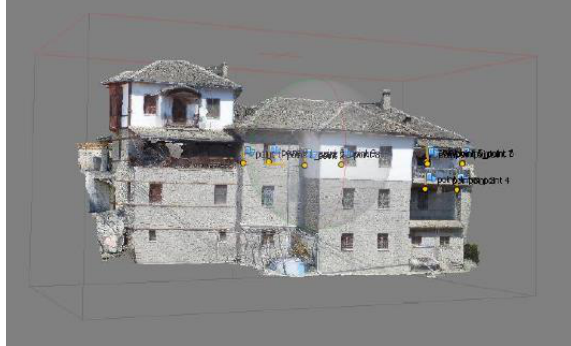
Figure 5: Textured mesh produced in Agisoft